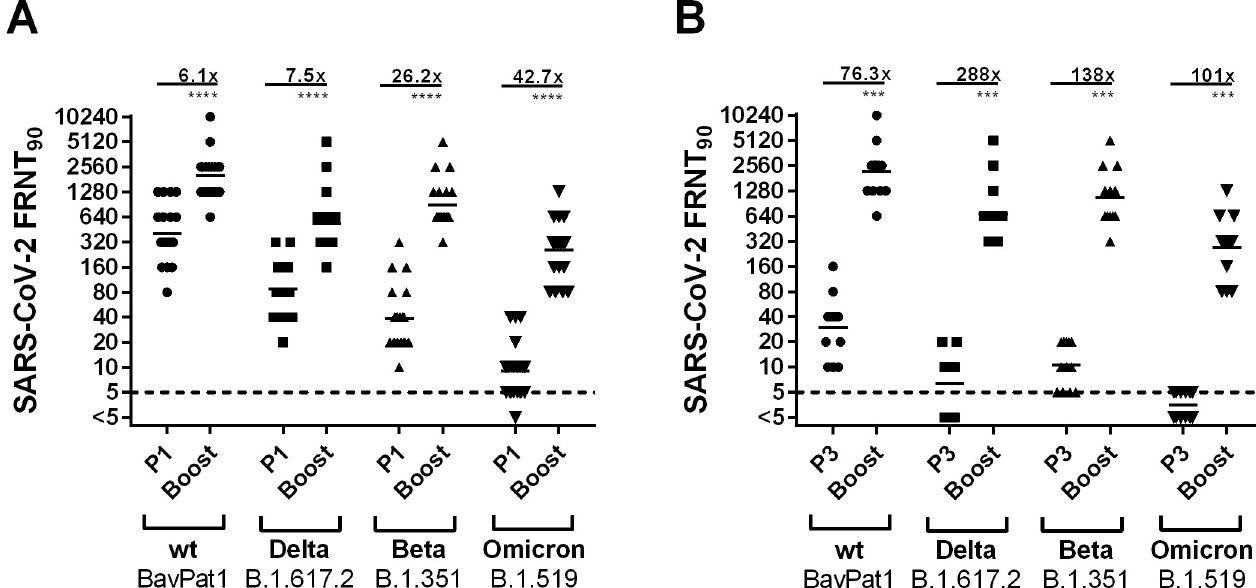
Fig 6. SARS-CoV-2 nAb titers on the wildtype strain wt-BavPat1 and the VOC strains Delta, Beta and Omicron after third vaccination (Boost) (A) compared to P1 two weeks after second vaccination and (B) compared to P3 8 months after first and third vaccination (Boost). Only individuals that had provided samples at both time points were compared. The dotted line indicates the limit-of-detection at a titer of 1:5. FRNT90: Focus reduction neutralization titer at 90% virus inhibition; results plotted as reciprocal values. Mean neutralizing titer reductions are depicted above the continuous lines � = p < 0.05, �� = p < 0.01, ��� = p < 0.001, ���� = p < 0.0001, ns = not significant.